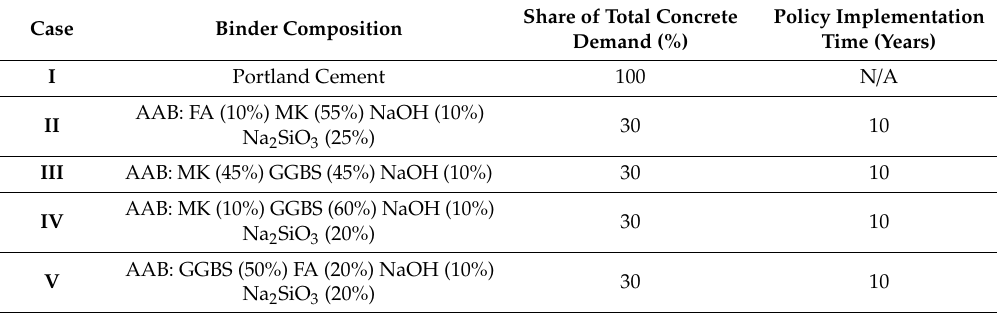
Table 4. Feasible AAB mixtures for futuristic scenarios.